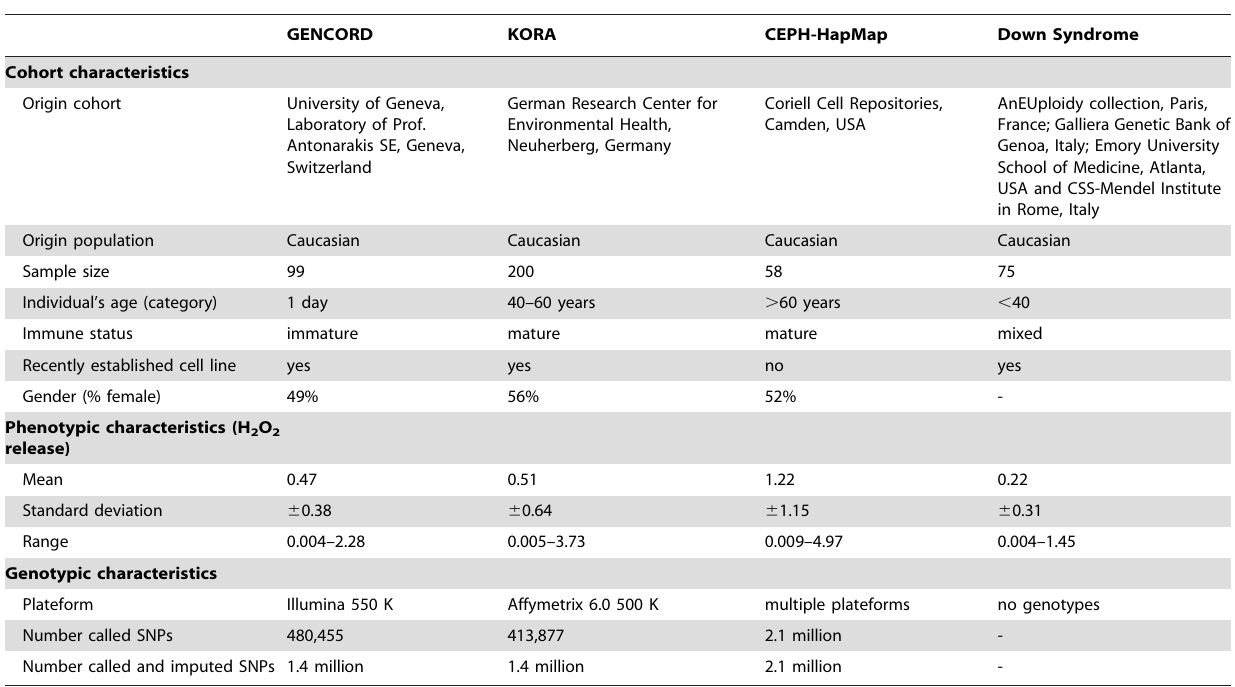
Table 1. Demographic characteristics for all four population-based cohorts.